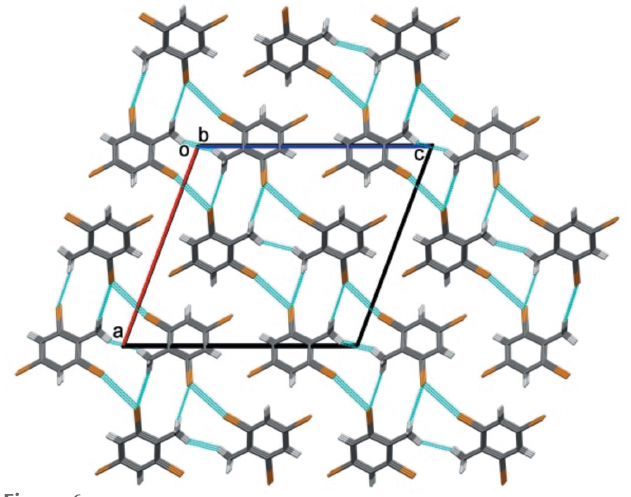
Figure 6 A view along the b axes of the crystal packing of 2,4,6-tribromotoluene, DBNT.